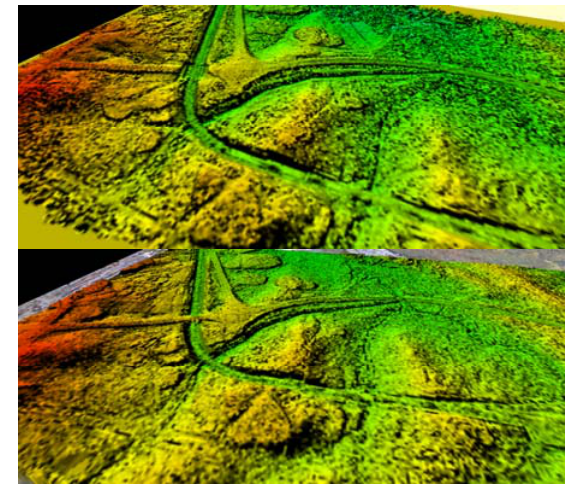
Figure 3. DEM from non-metric digital camera on UAS on top, DEM from LIDAR on